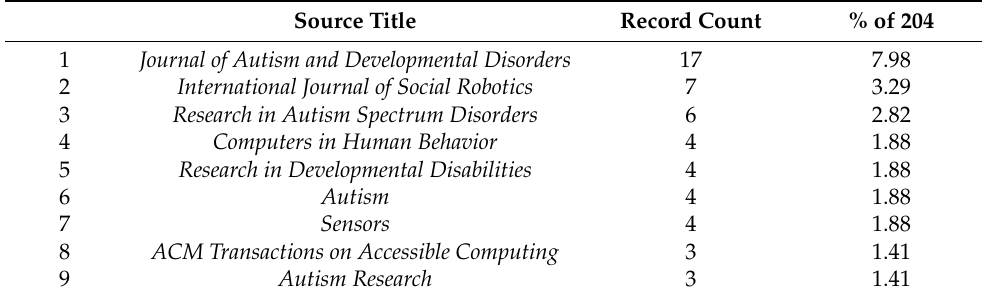
Table 3. Main journals of bibliographic